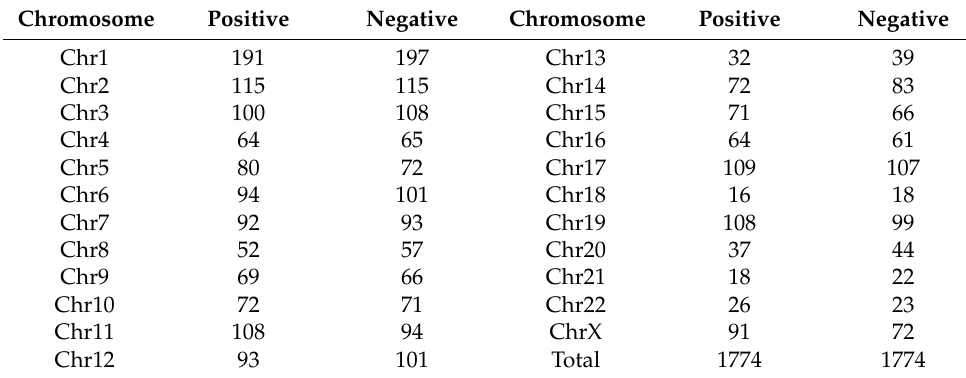
Table 4. The distribution of sample numbers in different